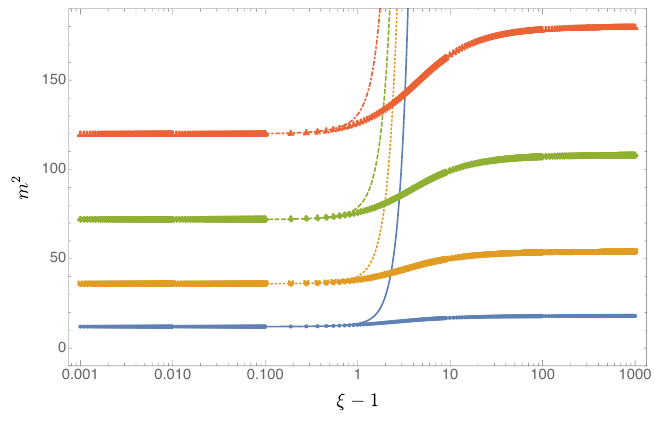
Figure 2 . The values of mass squared allowing for a regular scalar (cid:12)eld between the inner and outer horizons of RN-AdS, as a function of the near-extremality parameter ( (cid:24) (cid:0) 1). The lowest few solutions of the in(cid:12)nite tower are shown. The solid, dashed, dotted and dotted-dashed lines correspond to the perturbative result given by (3.8) with ‘ = 1 ; 2 ; 3 ; 4, respectively. The disks, squares, diamonds and triangles are the corresponding exact numerical